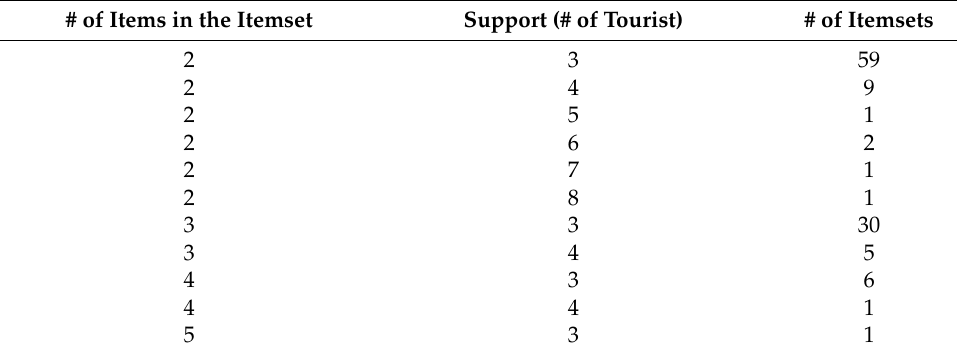
Table 6. Distribution of itemsets for Interpretation 3.